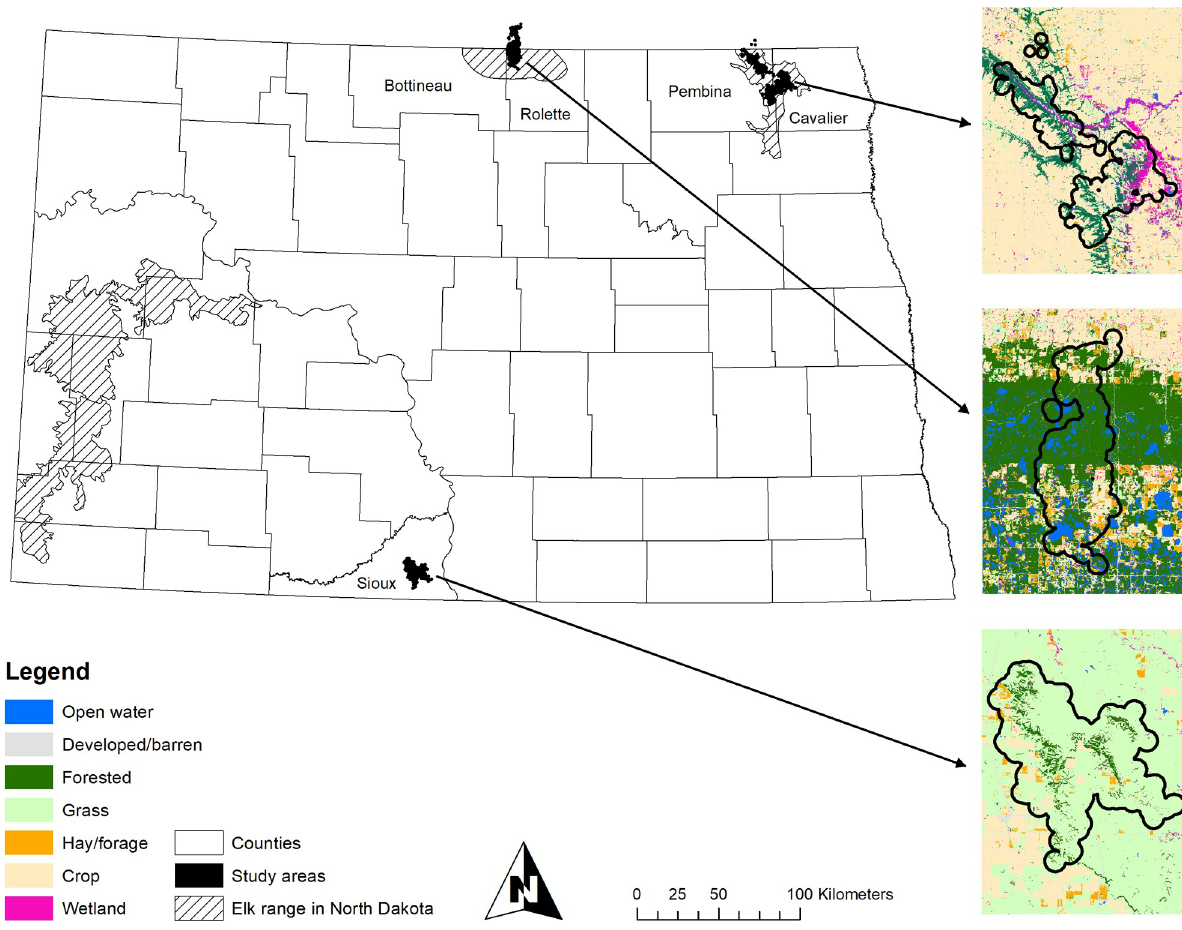
Fig 1. Study area map depicting aggregate elk home ranges with 1 km buffer, available land cover types within buffers, and known elk range in North Dakota prior to this study. Study areas included Turtle Mountain (Bottineau and Rolette counties), Pembina Hills (Pembina and Cavalier counties), and Porcupine Hills (Sioux County) regions, North Dakota, USA,